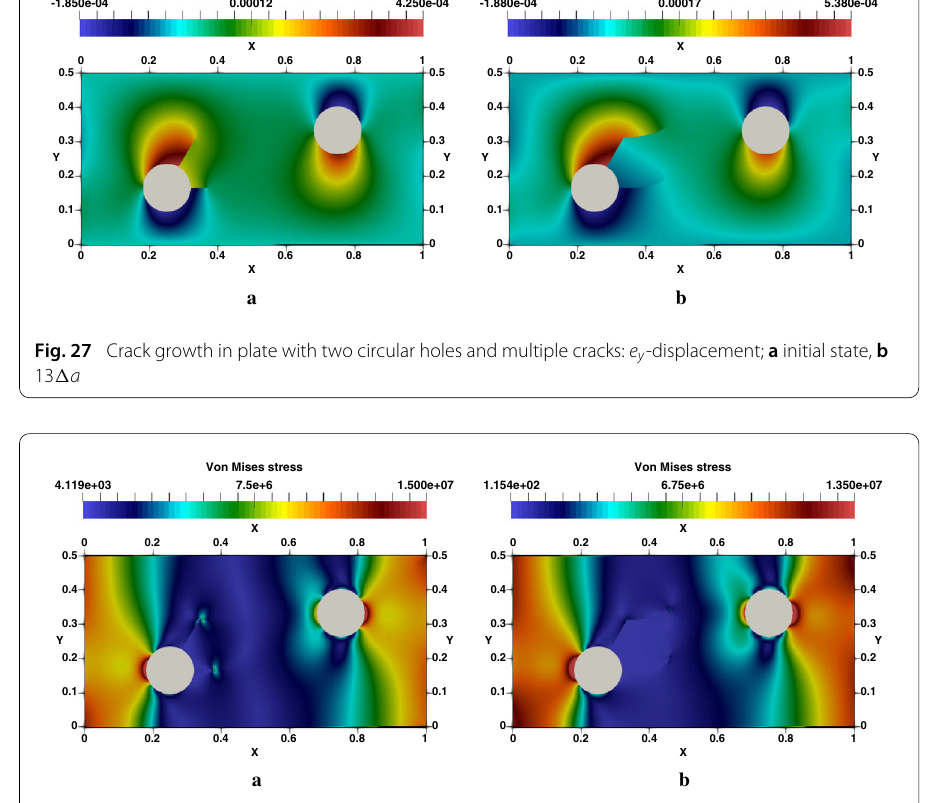
the full coupled XFEM part. The criteria for crack growth, as well as for the direction of the virtual crack extension are described, and their performance in the context